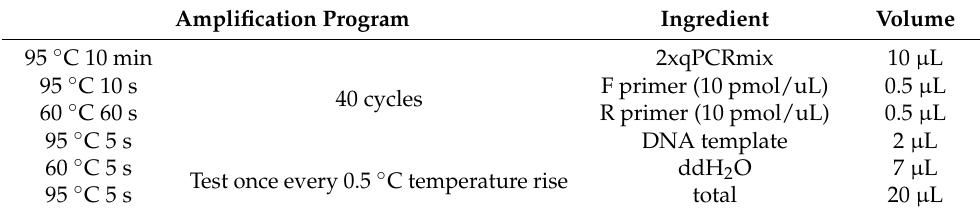
Table 4. Three tubes were prepared for each reverse transcription